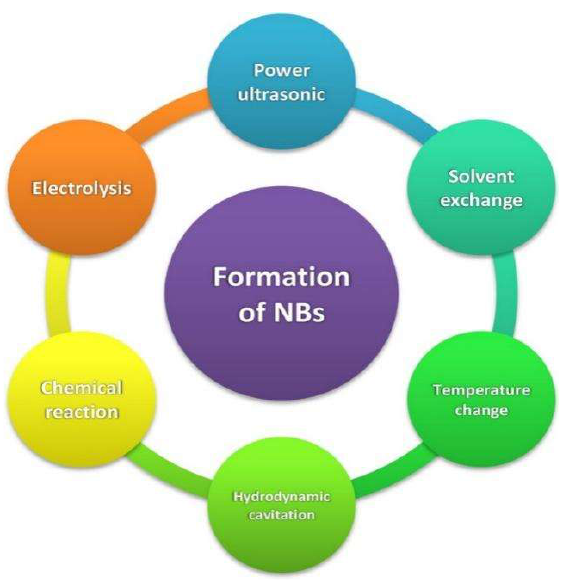
Figure 3. A schematic overview of commonly applied techniques for producing